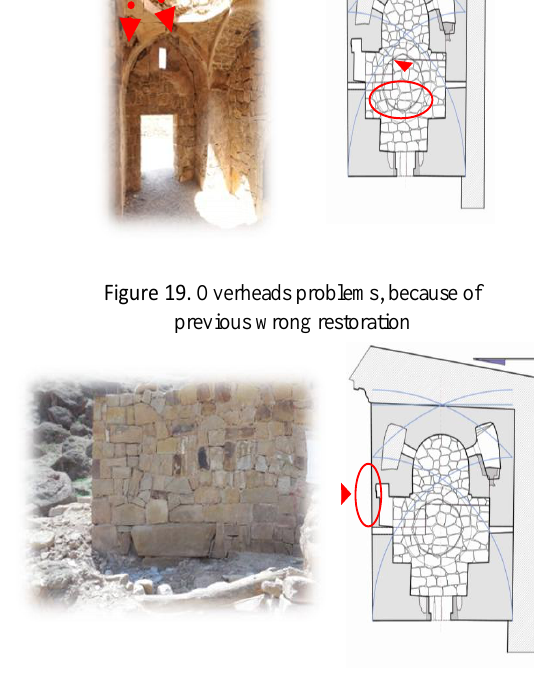
Figure 16. Completely destroyed of the dome problems